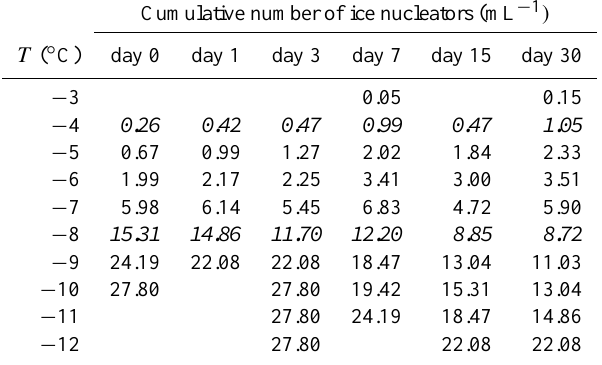
Table 1. Development of IN in snow water over 30 days during storage at 4 ◦ C. To observe the development, the same 208 sample tubes were repeatedly subjected to freezing tests. The lower limit of detection in this trial was 0.03, the upper limit was 27.80INmL − 1 . The number of IN active at − 4 ◦ C quadruplicated, while the number of IN active at − 8 ◦ C halved (indicated in italic).